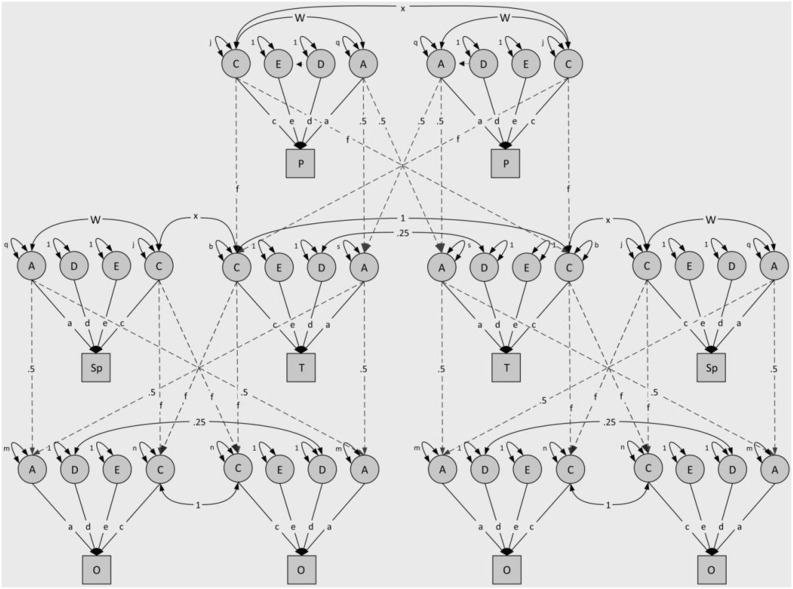
Genetic model for a DZ twin pair with parents, spouses and offspring.Notes: A = additive genetic effects, D = genetic dominance, E = non-shared environmental effects, C = shared environmental effects, f = cultural transmission path, w = gene-environment correlation, q = variance additive genetic effects, s = residual variance additive genetic effects twin generation, m = residual variance additive genetic effects offspring generation, j = variance shared environmental effects, b = residual variance shared environmental effects twin generation, n = residual variance additive genetic effects offspring generation, P = parent, T = DZ twin, Sp = spouse, O = offspring. Please note that additional siblings (and their spouses and offspring) are not included in the figure for reasons of convenience. Also note that only two children (per spouse pair) in the offspring generation are included in Figure 1 while a maximum of four is included in the analyses.